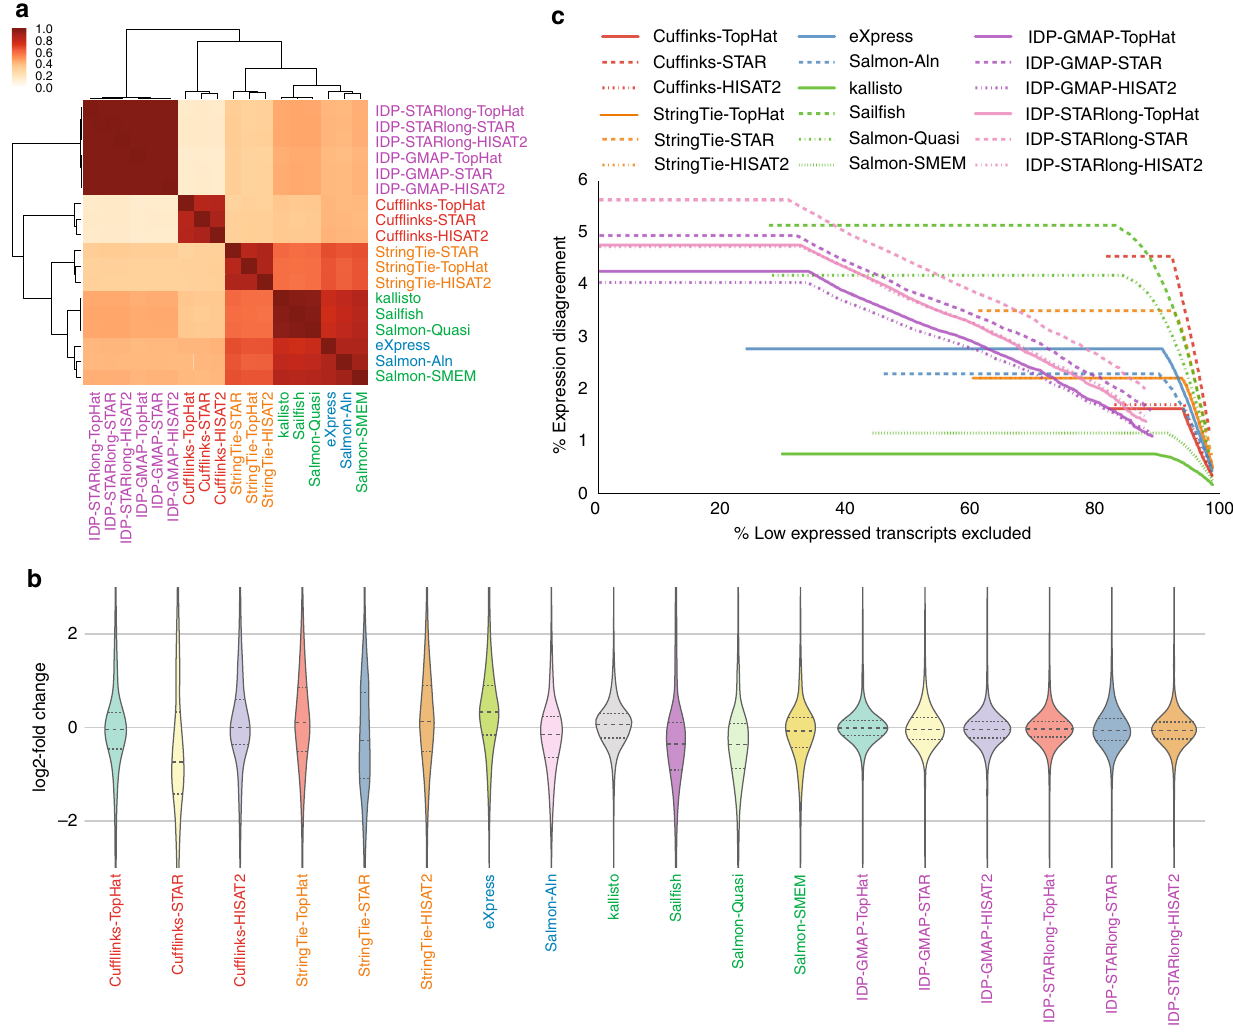
Fig. 5 Performance of transcript abundance estimators. a Clustering of different schemes based on the Spearman rank correlation of their log expressions on NA12878. b Distribution of log2-fold change of expressions between MCF7-100 and MCF7-300 samples. For each method, dashed line represents the mean of the distribution and the dotted lines represents the quartiles. c Percentage of expression disagreement between MCF7-100 and MCF7-300 samples when low-expressed transcripts are discarded with different